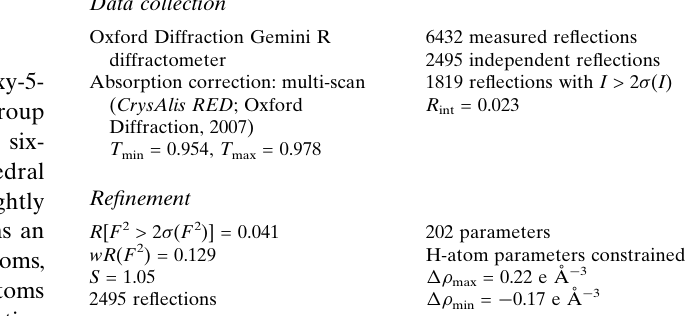
Data collection Oxford Diffraction Gemini R diffractometer